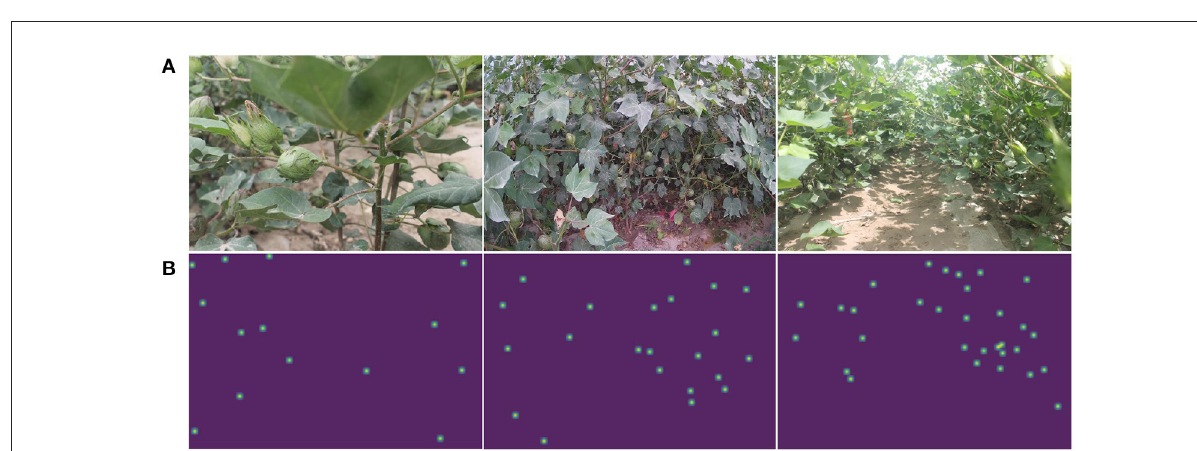
FIGURE2 Example of CBL dataset. (A) Is the original image, (B) is the corresponding